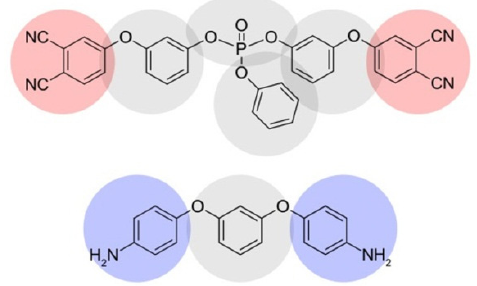
Figure 1. Chemical structures of the phthalonitrile monomer, bis(3-(3,4-dicyanophenoxy) phenyl) phenyl phosphate (DPPPP), and the initiator (diamine curing agent 1,3-bis(4-aminophenoxy)benzene, APB) with their coarse-grained mapping schemes. Red and blue beads have valences of two and one, respectively.